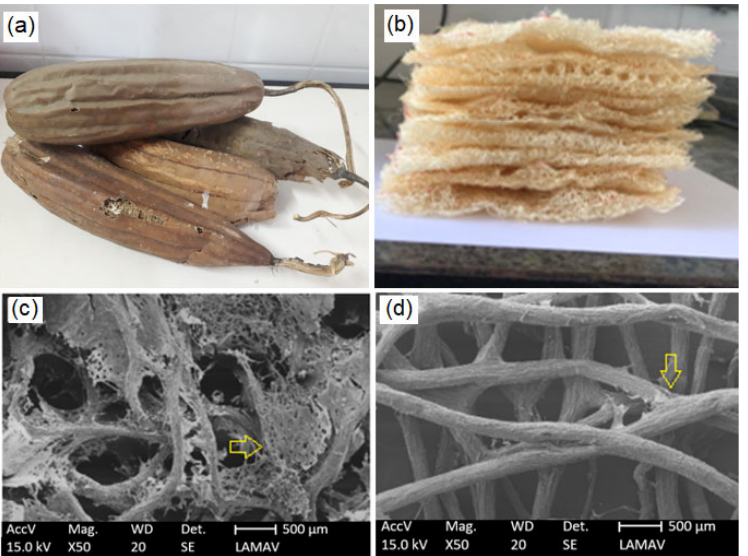
Figure 1. Naturally ‐ occurring luffa sponge gourd as received ( a ) and after the peeling off process ( b ), and SEMs photomicrographs of the luffa mat surface before ( c ) and after the cleaning process ( d ). The arrows point to some of the sites where the fibers are naturally bonded together, forming a mat.